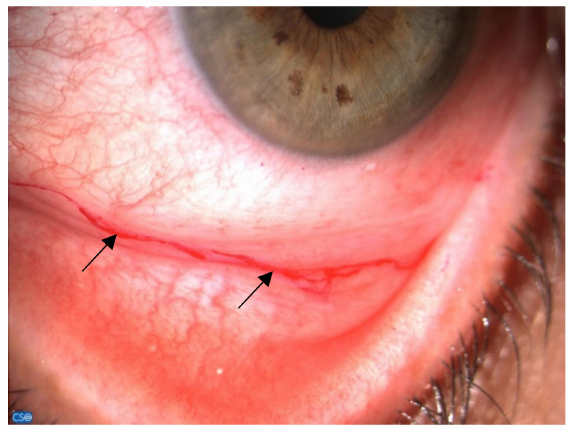
Figure 2. Rose bengal-colored mucus filaments (black arrows) in the lower